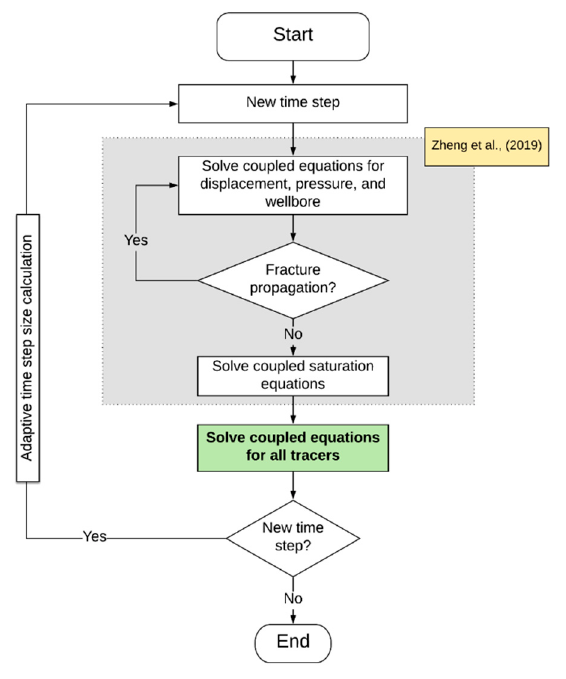
Figure 3. Block flow diagram for the tracer transport model integrated in the geomechanical reservoir simulator.